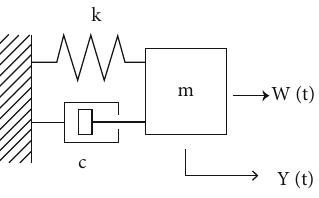
Figure 2: The SDOF